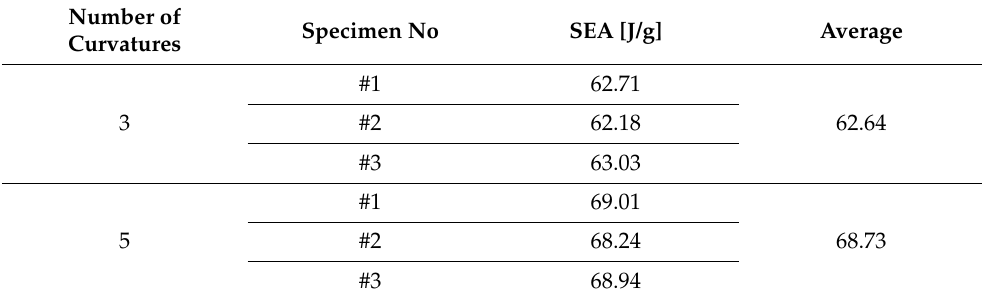
Figure 11. Load-displacement curves of the sinusoidal specimens with 3 ( left ) and 5 curvatures ( right ). Table 4. SEA values of the semi-circle specimens.